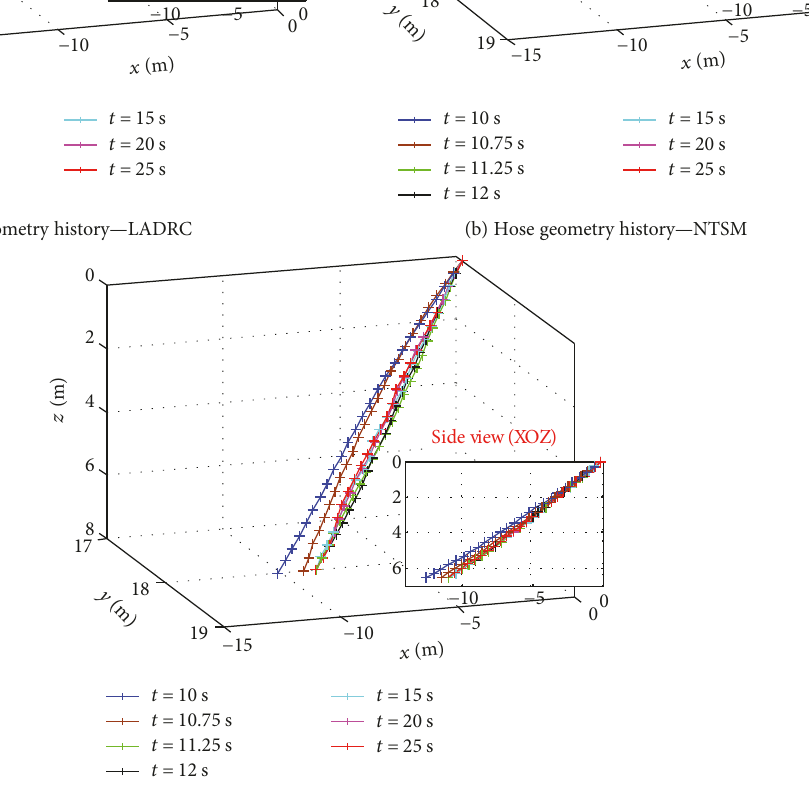
Figure 15. And the length histories of the hose reeling driven by the PMSM are shown in Figure 16.